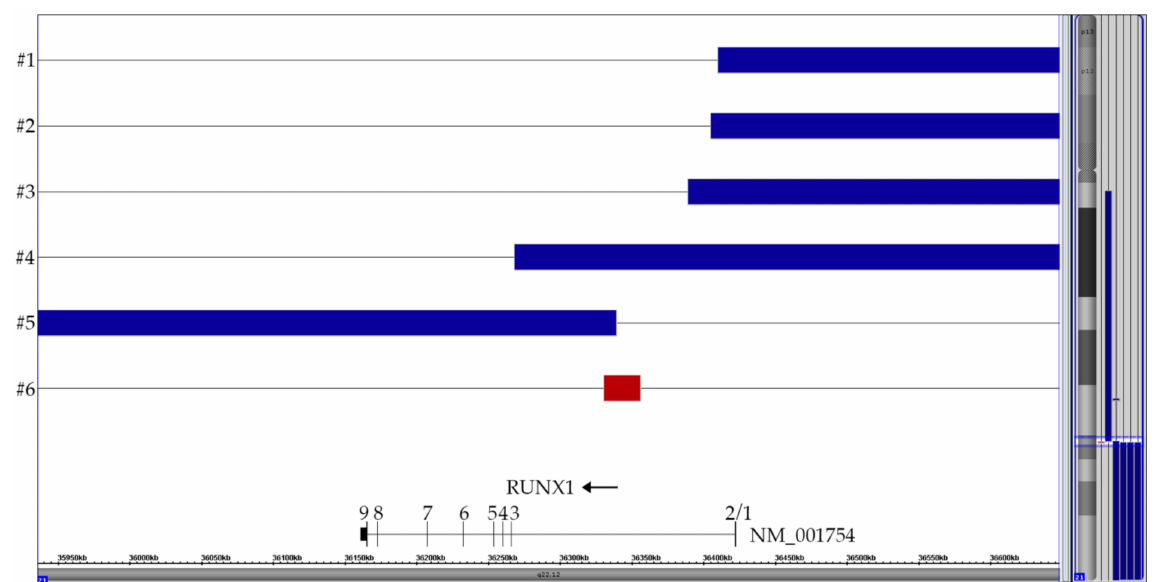
Figure 2. Summary of the six partial chromosome 21 CNAs that are all the direct or indirect byproduct of the t(12;21) with its ETV6-RUNX1 gene fusion, respectively. Only the relevant part surrounding the RUNX1 breakpoint in intron 2 is shown. The horizontal top four blue lanes represent cases with two der(12) copies, the bottom blue one the case with a duplicated der(21) and the red one the case with the small breakpoint-associated 25 kb deletion (72 markers). The corresponding vertical lines on the right of the ideogram indicated the respective extent of these CNA on chromosome 21.